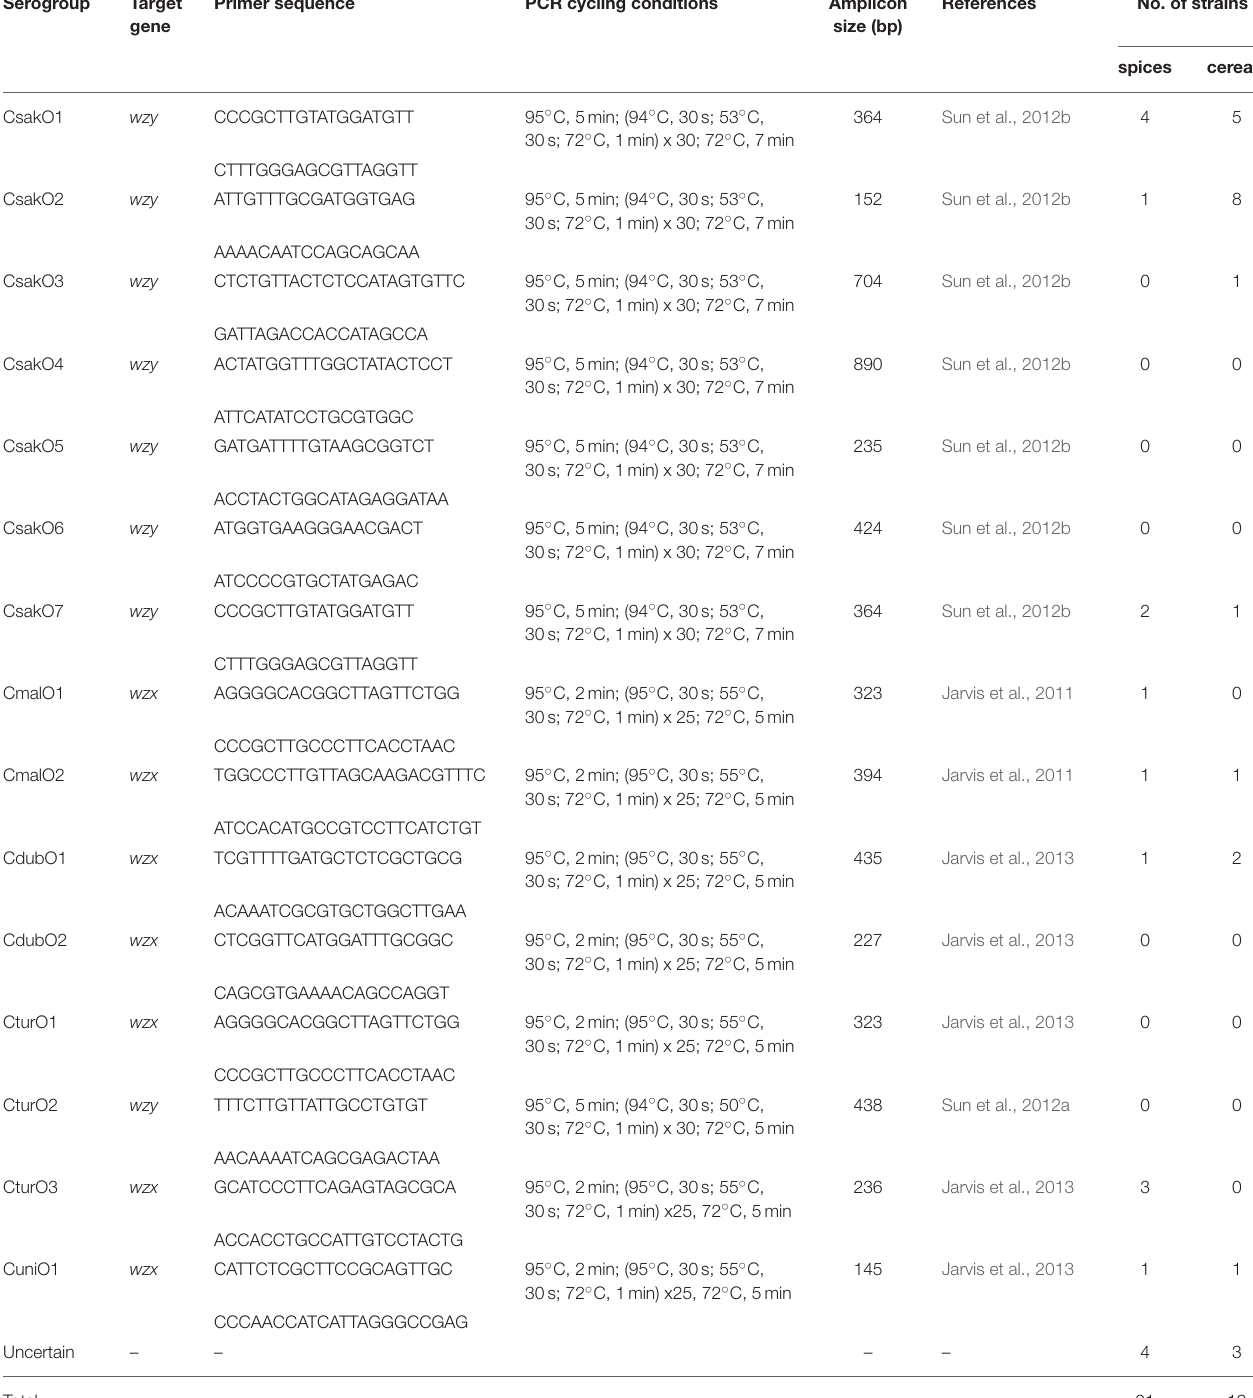
TABLE 2 | Lists of primers and PCR cycling conditions used for serotyping of Cronobacter strains.